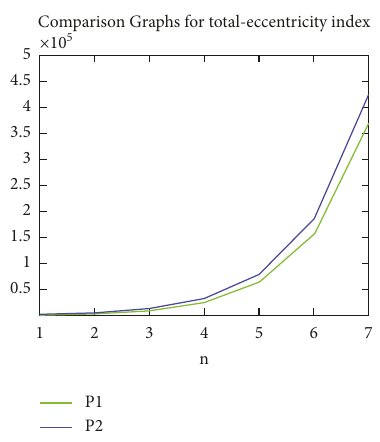
Figure 5: Graphical comparison between TEI of P